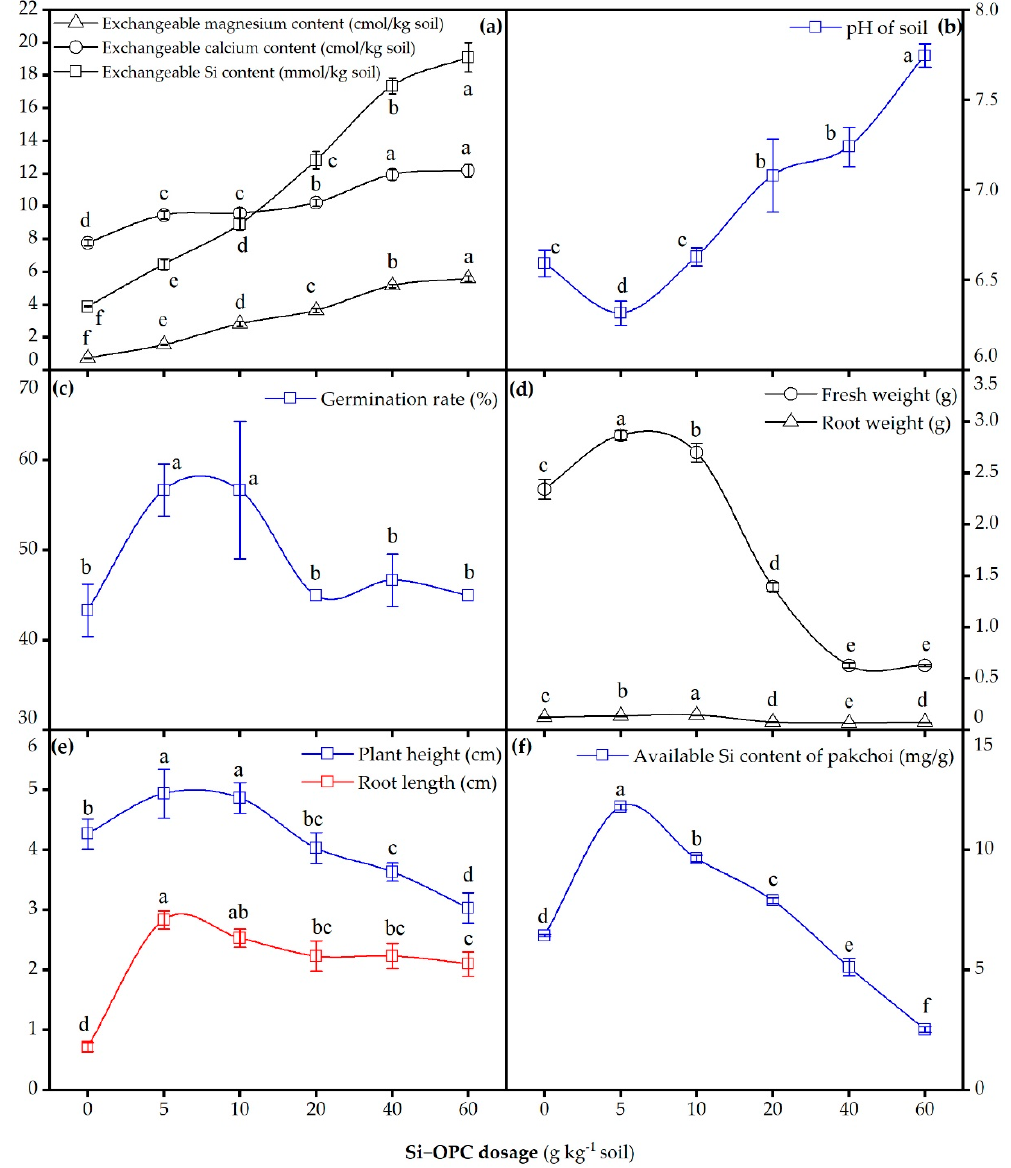
Figure 8. Effects of Si-OPC dosage (0–60 g kg − 1 soil) on ( a ) exchangeable magnesium, calcium and Si content and ( b ) pH of soil as well as ( c ) germination rate, ( d ) fresh weight and root weight, ( e ) plant height and root length and ( f ) available Si content of pak choi. Means with different letters above the spots are statistically different from each other at p < 0.05.